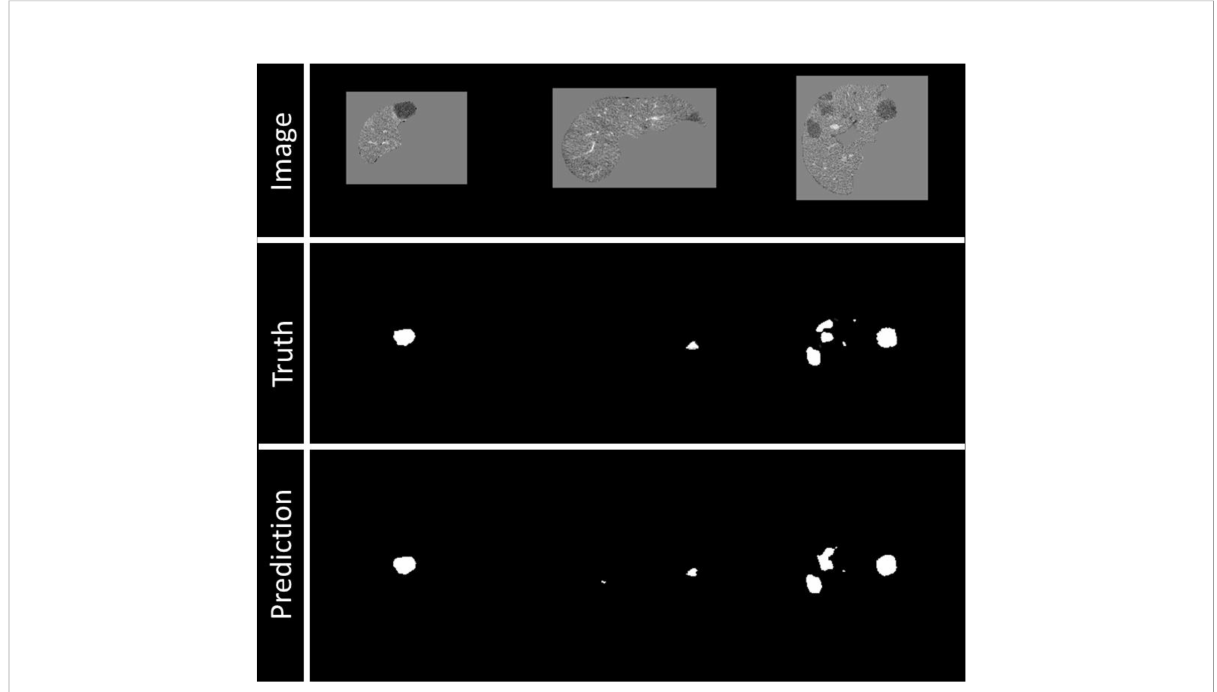
FIGURE 4 Example of visualization of prediction on validation data during training. Top row: Image being fed into the model, masked by the liver segmentation. Middle row: Ground truth of disease contours. Bottom row: Prediction of disease contours, set with a threshold of 0.5 to the binary